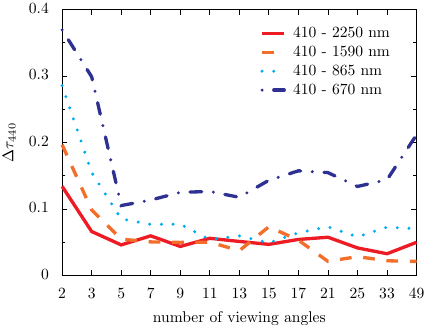
Figure 10. Retrieved AOD mean absolute error dependence on number of viewing angles for different spectral ranges of RSP data.